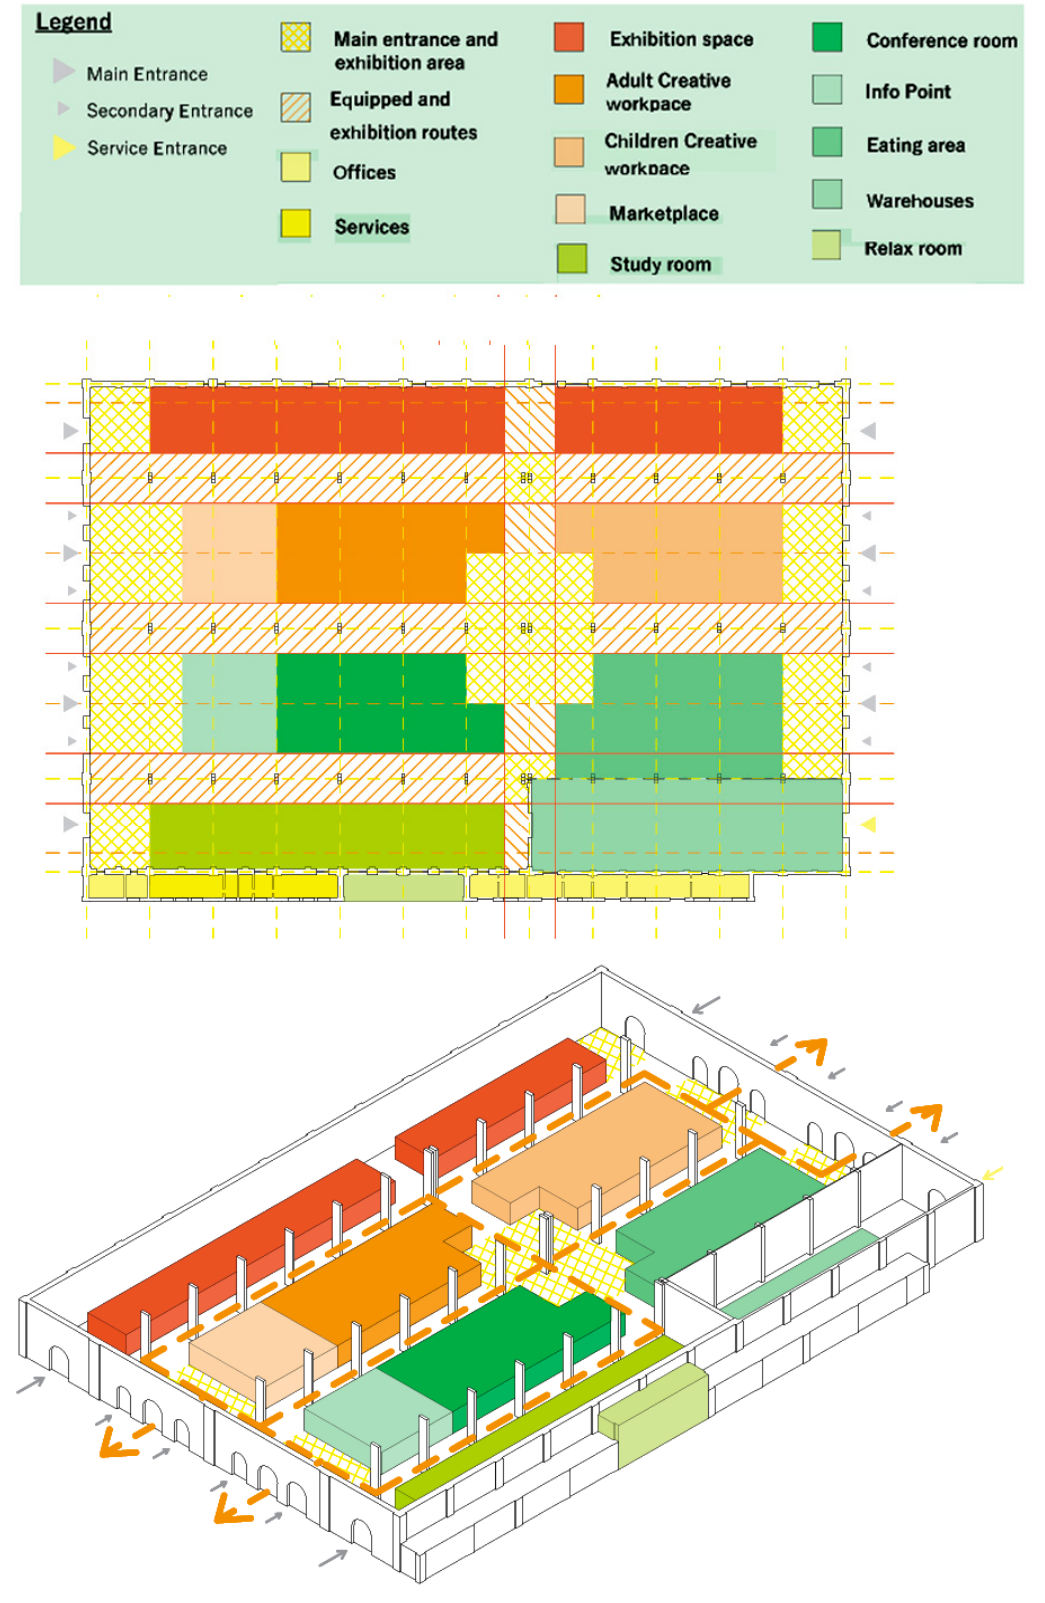
Figure 5. Identification of functional Figure 5. Identi fi cation of functional macro-areas.